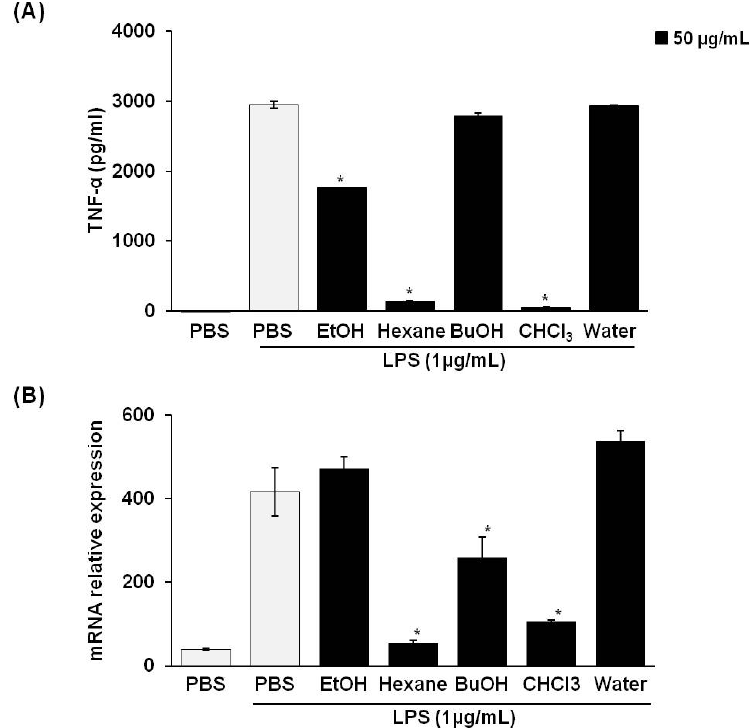
Figure 4. Effects of solvent fractions from Prunella vulgaris var. lilacina on LPS-induced TNF α levels ( A ) and TNF α mRNA expression ( B ) in RAW 264.7 cells. Cells were treated with fractions (50 μ g/mL) and stimulated with LPS (1 μ g/mL) for 12 h. Values show the means and standard deviations of three different experiments performed in